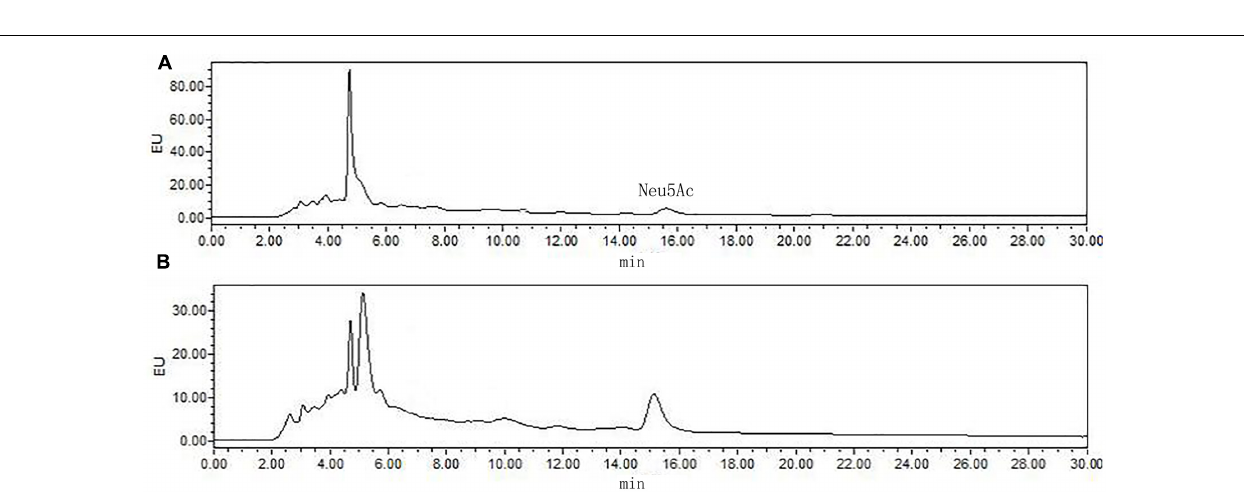
Frontiers in Pharmacology |